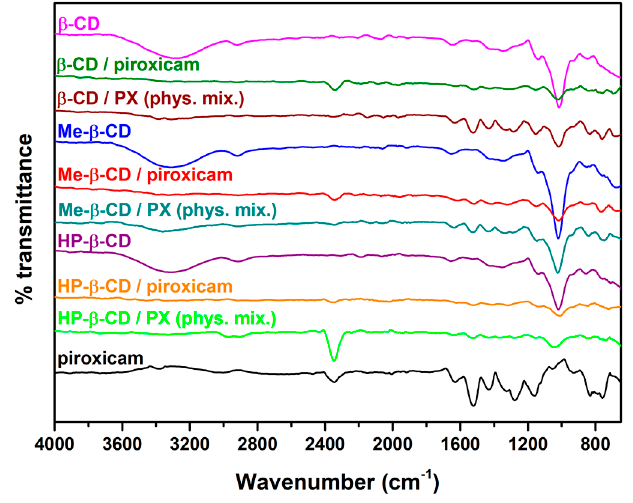
Figure 4. FTIR spectra of pure components and binary systems.